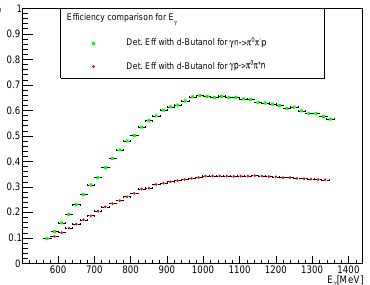
method. Before that, e ffi ciency comparison of the two in- terested channels has been presented below.